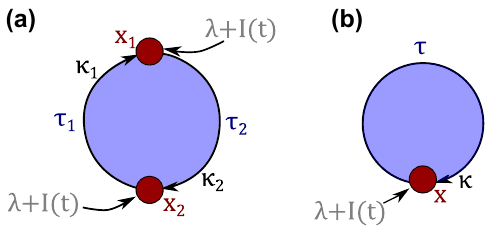
Figure 2: Delay-coupling schemes used for the reservoir: (a) Two arranged in a delay-coupled ring topology, oscillators x j corresponding to Eq. (9) where each oscillator is unidirectionally . Every node is externally coupled to the next oscillator with delays 𝜏 j . The input I ( t ) = g ( t ) u ( t ) is fed in via the driven with pump rate 𝜆 j j pumping. (b) Same setup as in (a), but with one oscillator subjected to delayed feedback.